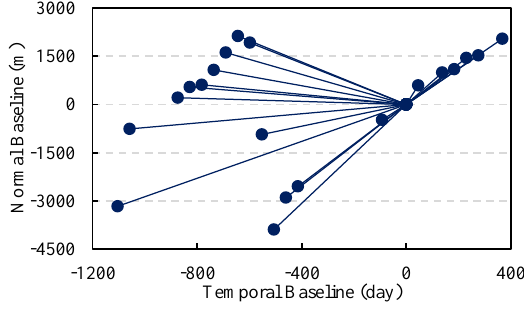
Figure 12. Distribution of the temporal baselines and the normal baselines.